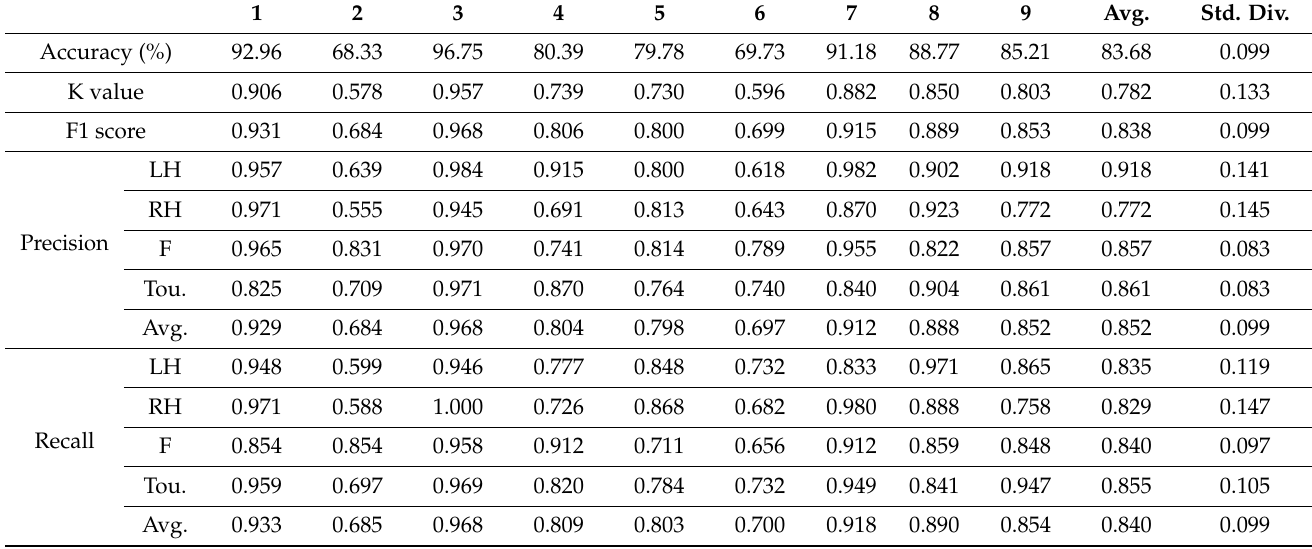
Table 6. Performance metrics on the BCI-IV2a dataset using the